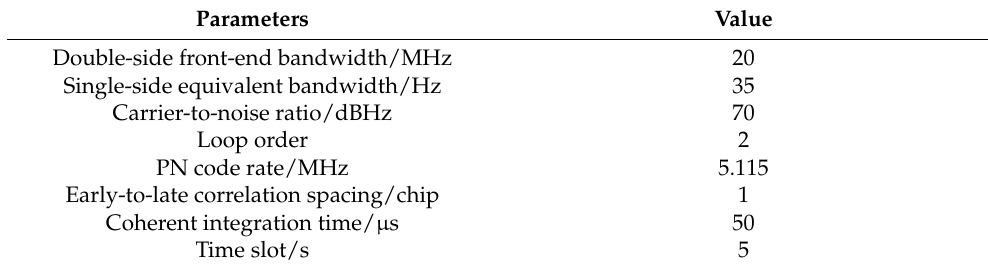
Table 1. Parameter setup.